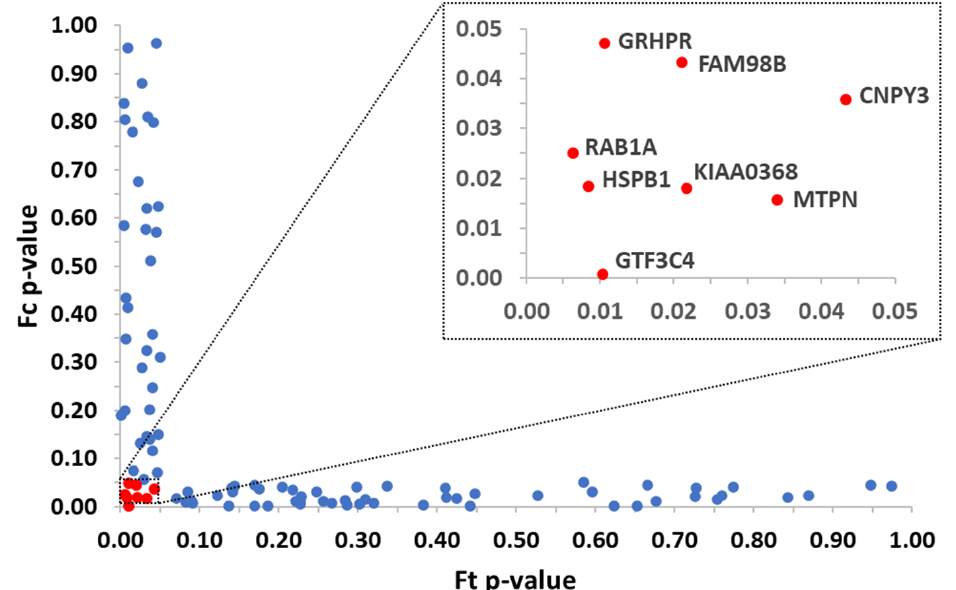
Figure 2. Protein targets were identified by the 2D PISA method for TCDD and the soluble proteome from hepatocytes. The studied concentrations were 100, 90, 80, 70, 60, 50, 40, 30, 20, and 0% (concentrations from 20 to 90% were pooled for the MS/MS analysis and the obtained data were used to calculate F c while data from 100% concentration were used to calculate F t ). The highest concentration (100%) corresponds to 25 nM TCDD. Identified protein targets are shown in red and labeled. Significant proteins for F t or F c are shown in blue. (For interpretation of the references to color in this figure legend, the reader is referred to the web version of this article).